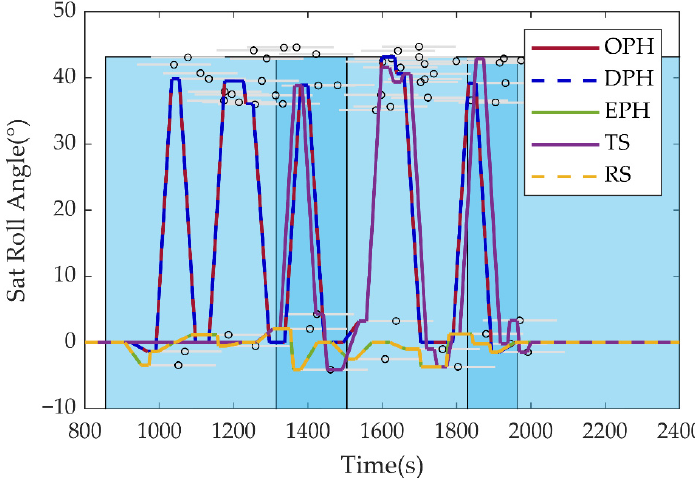
Figure 15. Targets selection and observation path diagram of a single condition in the third group.